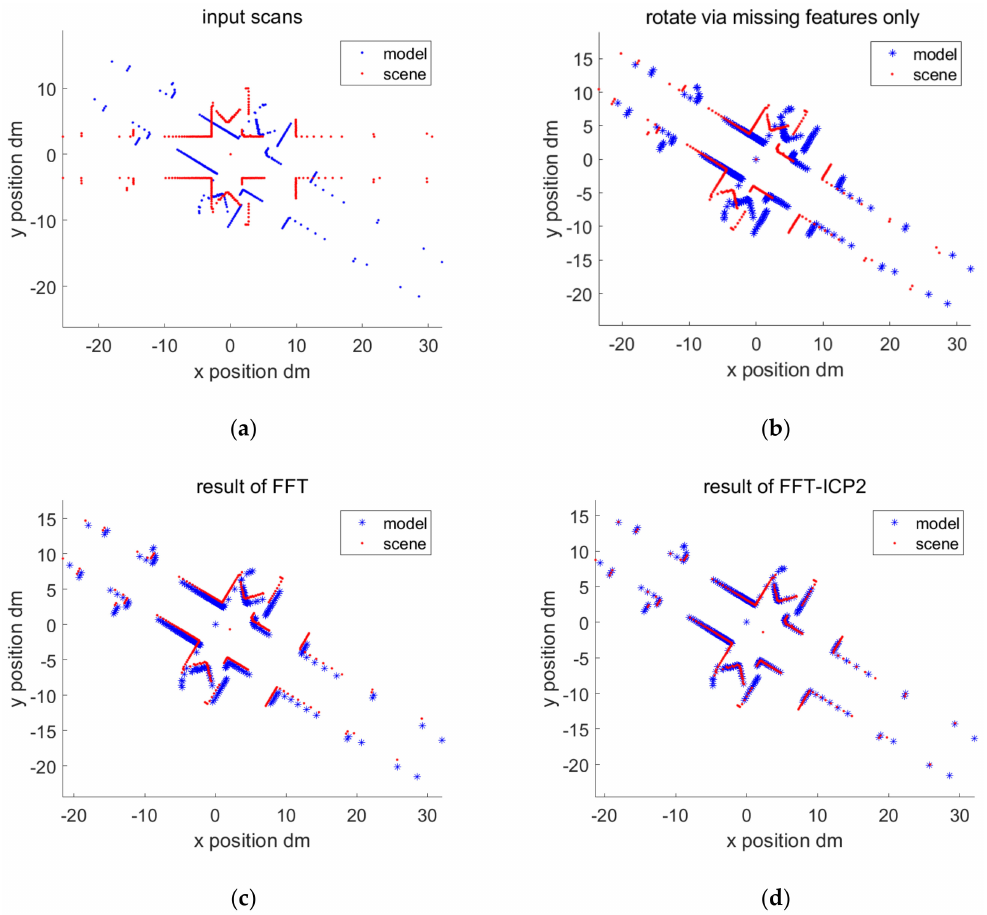
Figure 8. An example of matching result with proposed method. ( a ) The input scan data; ( b ) rotation via the angle estimated by missing data features; ( c ) the matching result with rough posed estimate by FFT; and ( d ) the final